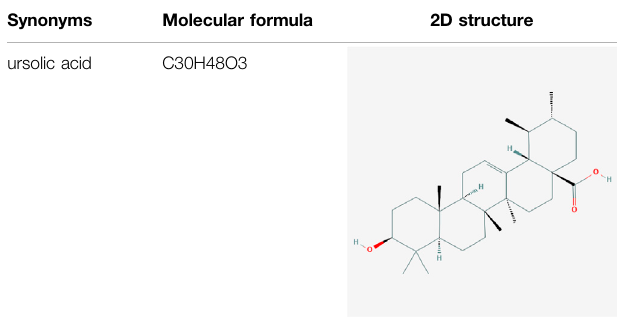
TABLE 3 | ( Continued ) The chemical structure of Huangqi Jianzhong Tang bioactive